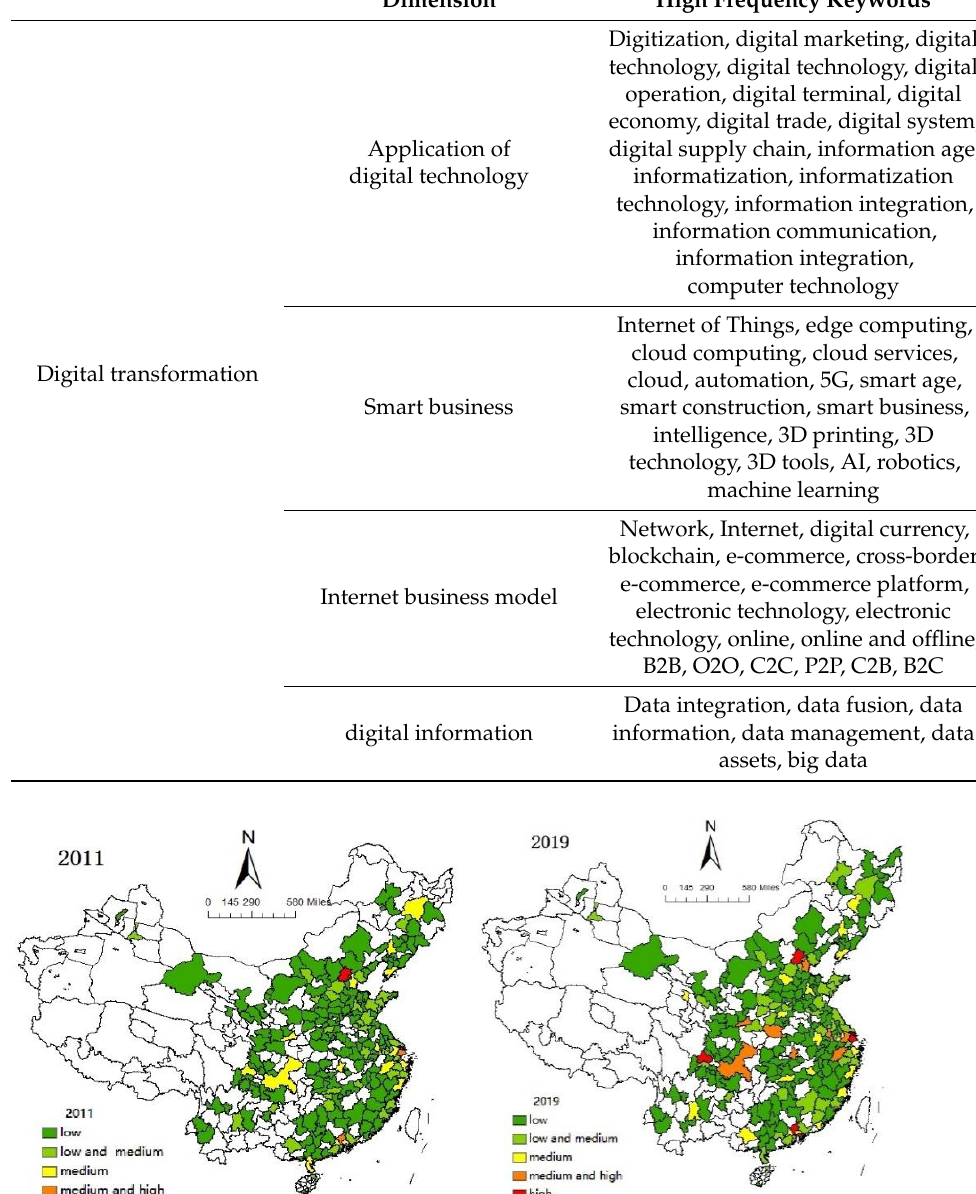
Table 1. Index system of digitalization level.